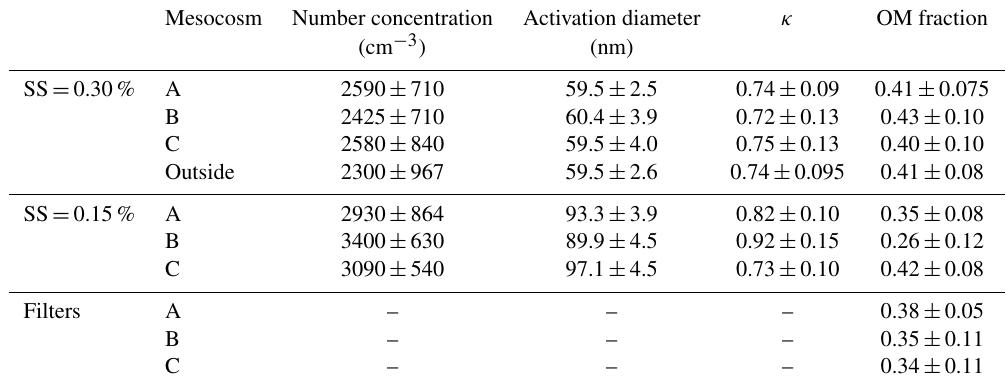
Table 2. Average number concentrations, activation diameters, kappa values ( κ ) and organic fractions for each mesocosm at both supersatu- rations tested. Organic fractions from the filter collections ( < 1000nm) are also shown for all three